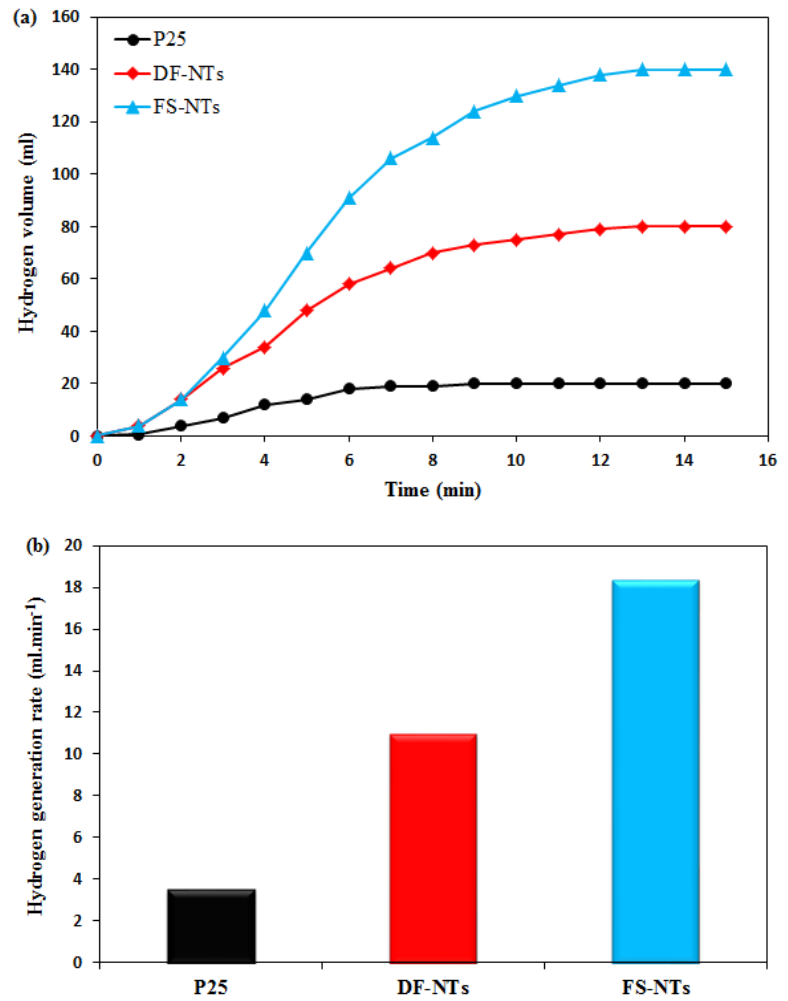
Fig. 6. The influence of different catalysts on (a) volume of generated hydrogen and (b) rate of generating